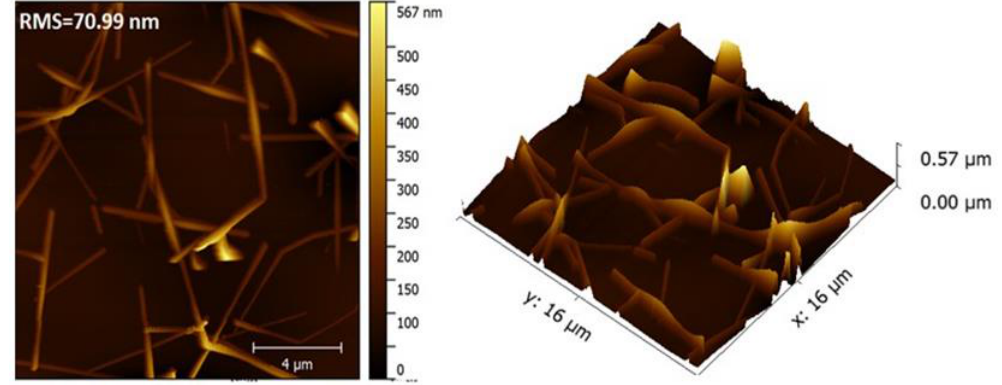
Figure 5. Topological atomic force microscopy (AFM) images of LBL assembled AgNWs film on glass.